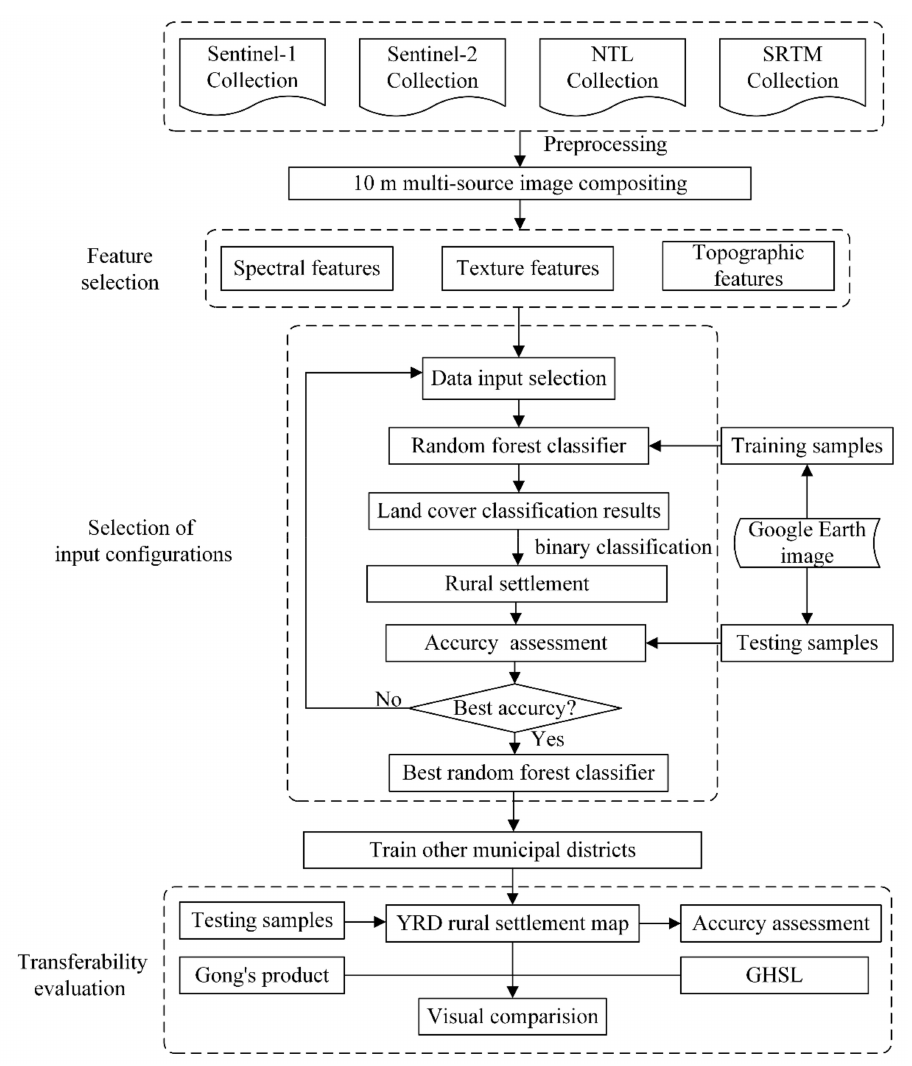
Figure 2. Flowchart of the proposed